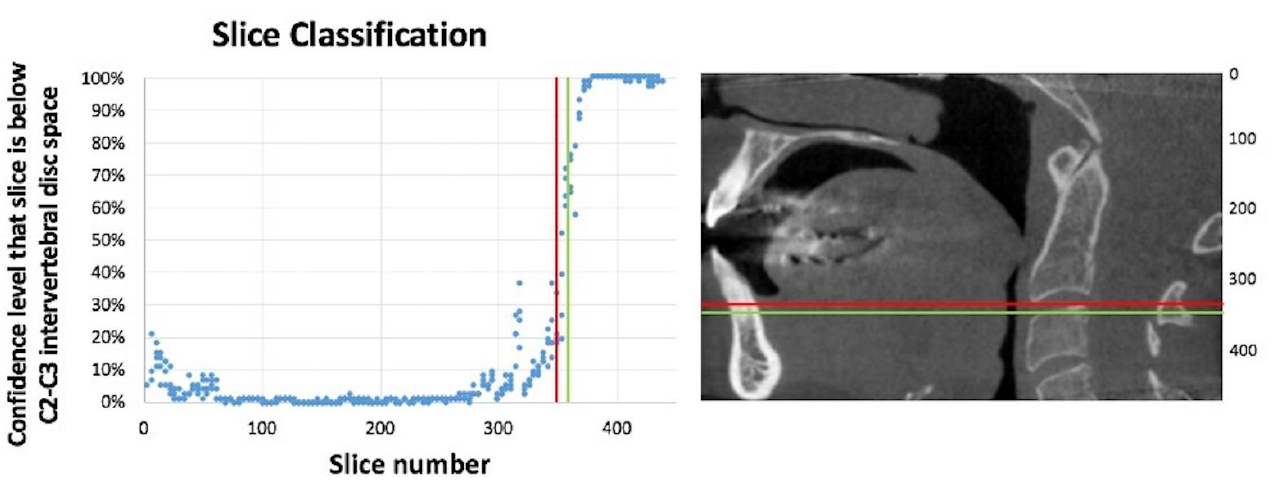
Figure 8. This graph shows the slice number selected by the neural network compared to the slice number selected by the radiologist as the C2–C3 intervertebral disc space for a complete test DICOM study that was not part of the training. The red line (slice 345) was selected by the radiologist, and the green line (slice 357) was selected by the neural network using linear regression. The results for all DICOM studies in the test set were within 15 slices of the correct value. Table 1. Distribution of slices with and without CAC and those detected and not detected by the neural network.